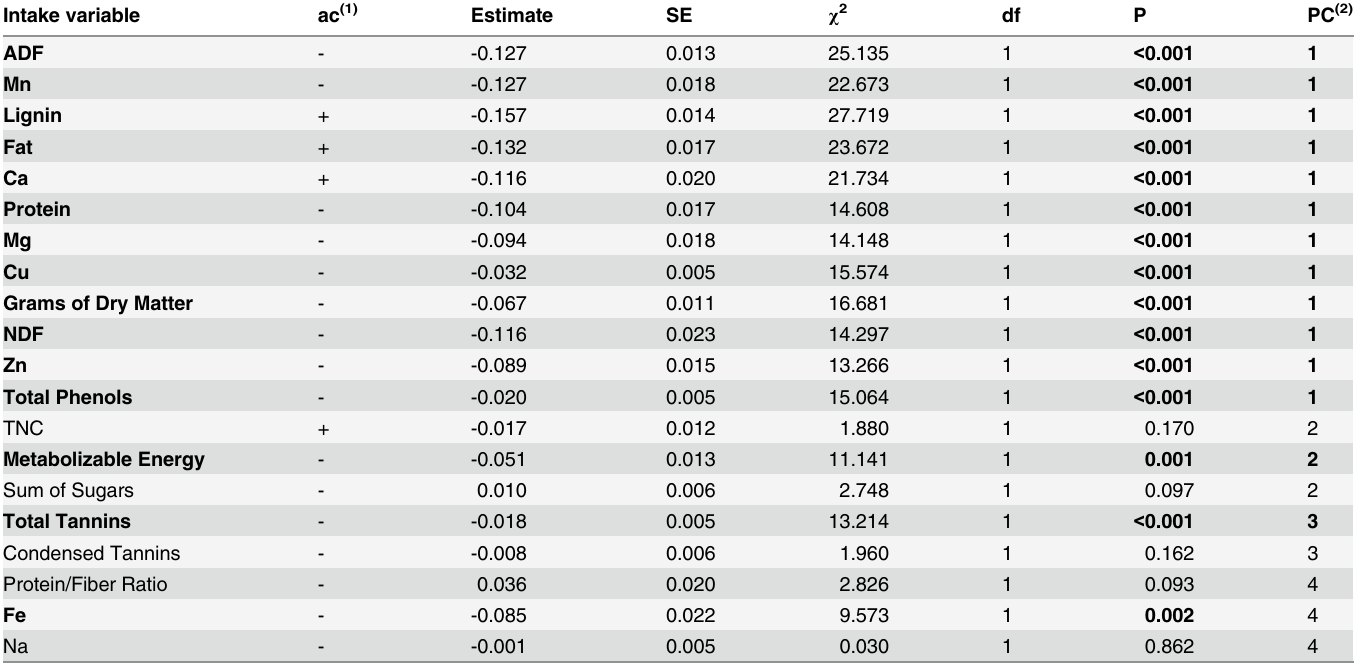
Table 5. Results of GLMMs with the individual nutrient variables as the response analysed one at a time, showing the influence of fruit availability index (FAI) on all intakes. Intake variable